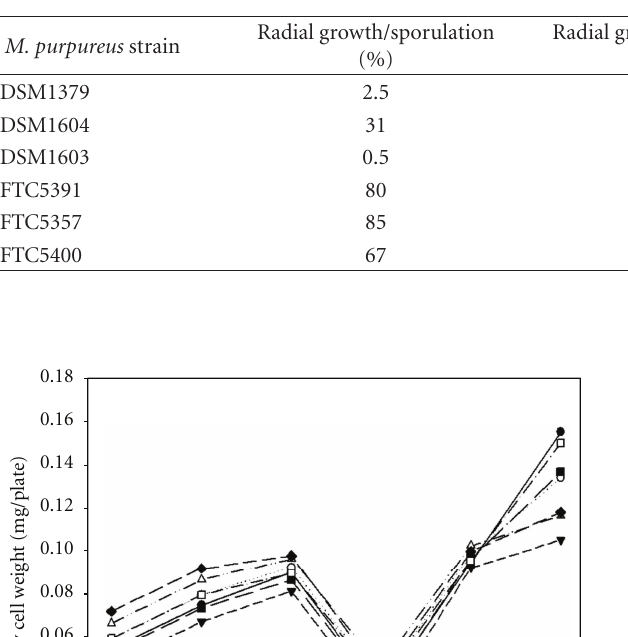
Table 4: Correlation between radial growth, cell mass production, and sporulation of M. purpureus strains cultivated on di ff erent solid media.